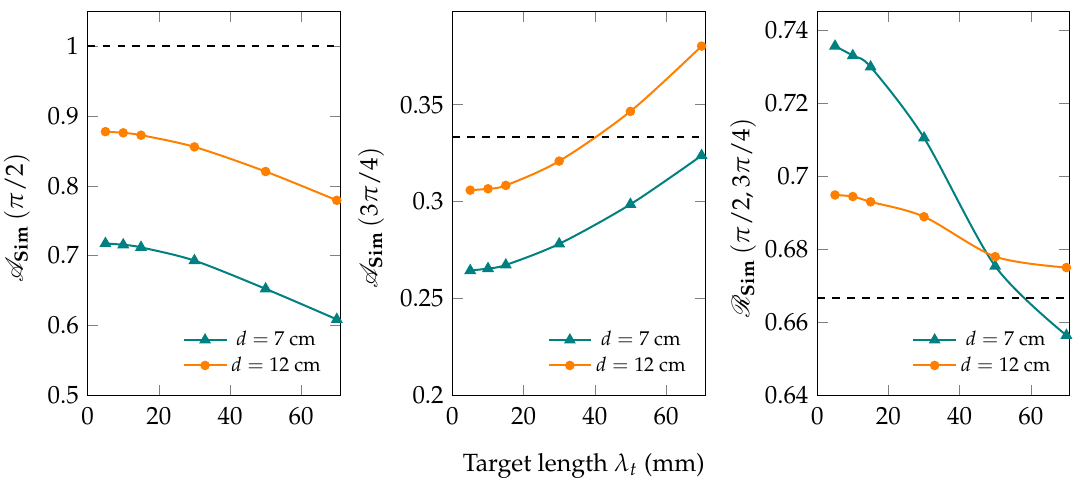
Figure 5. Dependence of the asymmetries A Sim ( π /2 ) and A Sim ( 3 π /4 ) , and the angular distribution ratios R Sim ( π /2,3 π /4 ) on the target length at different target-to-detector distances for the dipole transition with a spin sequence of 0 → 1 → 0. The detector radius is fixed at R d = 45 mm while R t = 5 mm. The exact values corresponding to the point target and point detector are expressed by dashed lines.